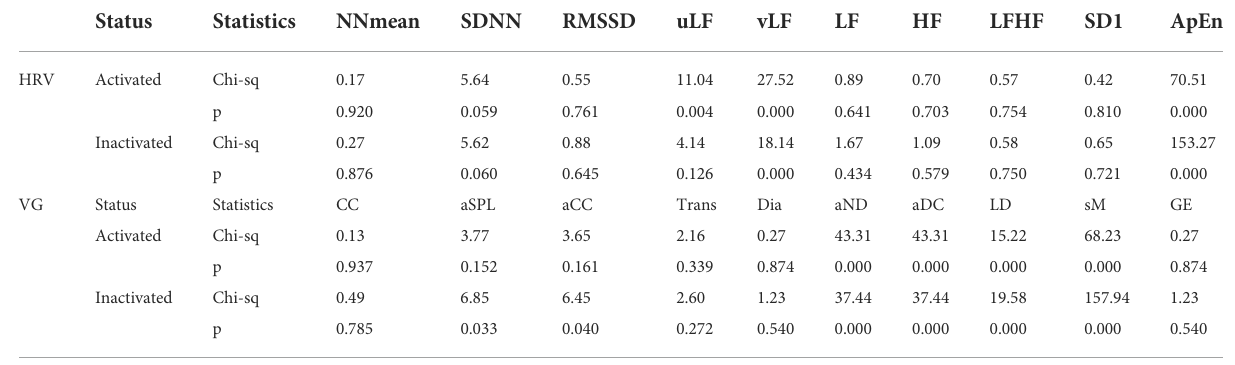
TABLE 2 The KW test results of feature distribution differences in different data lengths.